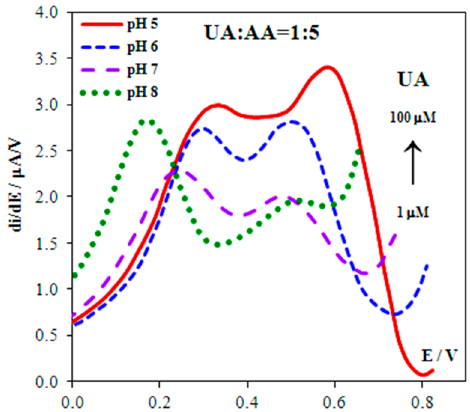
Figure 6. Derivative anodic voltammograms of 0.1 mM UA and 0.5 mM AA at the 2.5% Nf/Au(5nm)/CSPE in background solution with different pH.